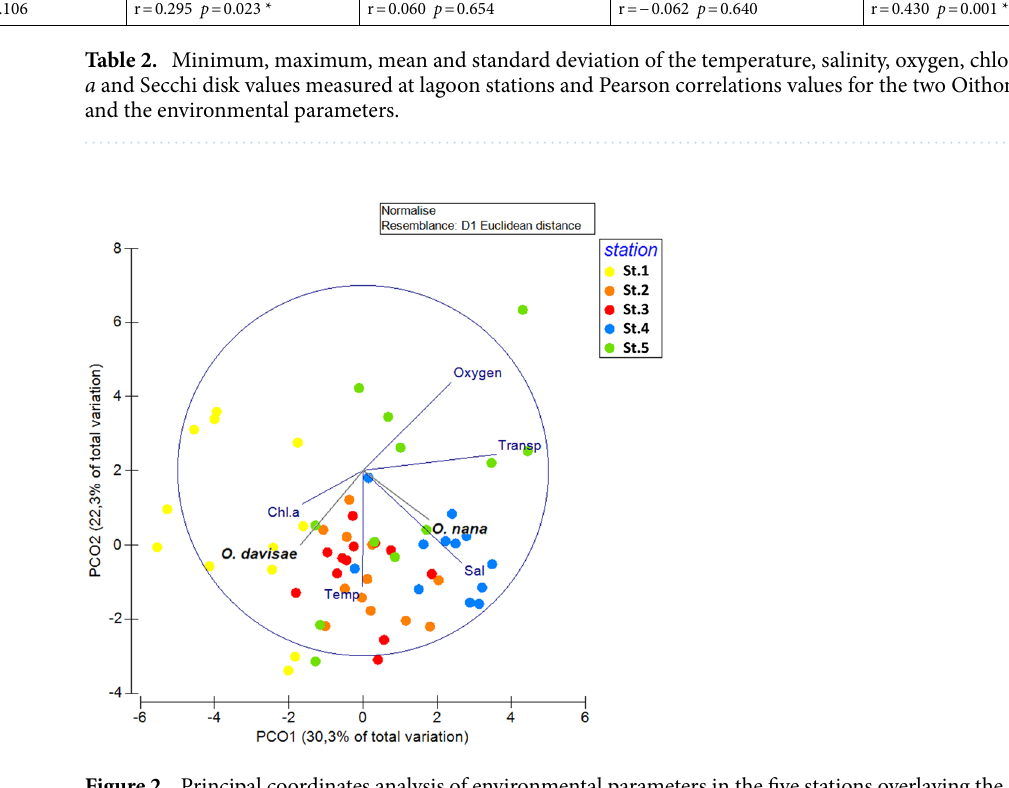
Figure 2. Principal coordinates analysis of environmental parameters in the five stations overlaying the correlation with the abundance of the two